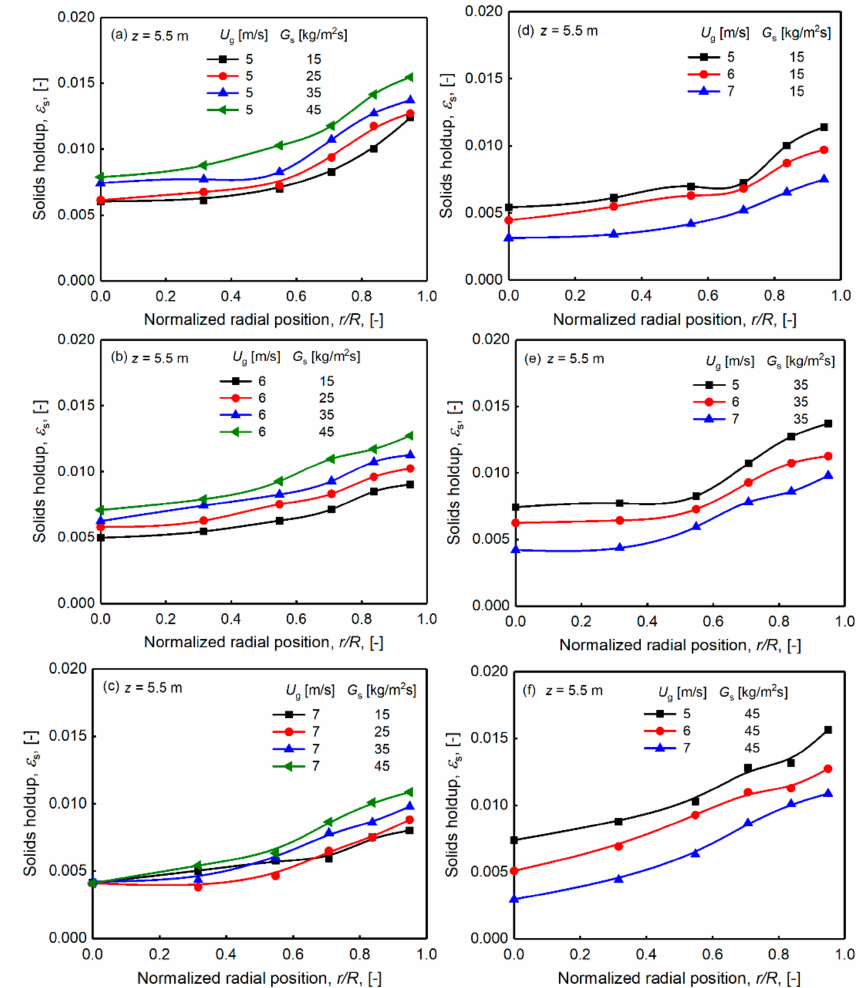
Figure 6. Radial distributions of solids holdup under various operating conditions. (( a – c ) represents the axial distribution of solids holdup of particles under different particle circulation rates. ( d – f ) represents the axial distribution of solids holdup of particles at various superficial gas